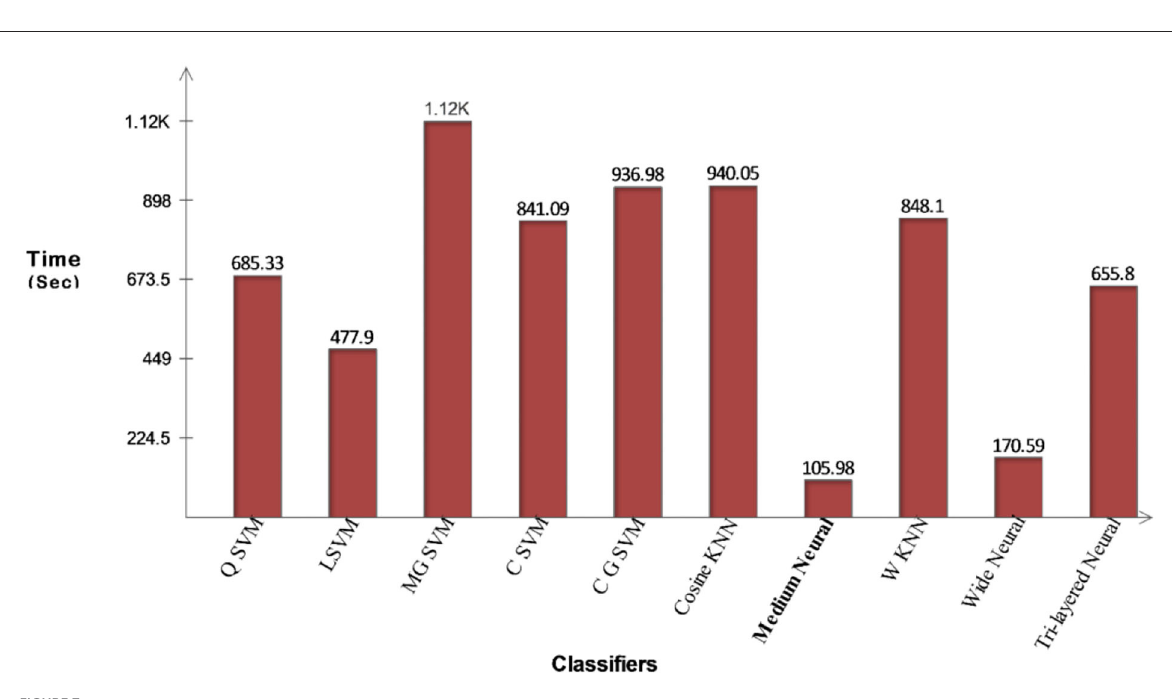
FIGURE7 Illustration of computational time for COVID-19 Radiography Database after proposed fusion